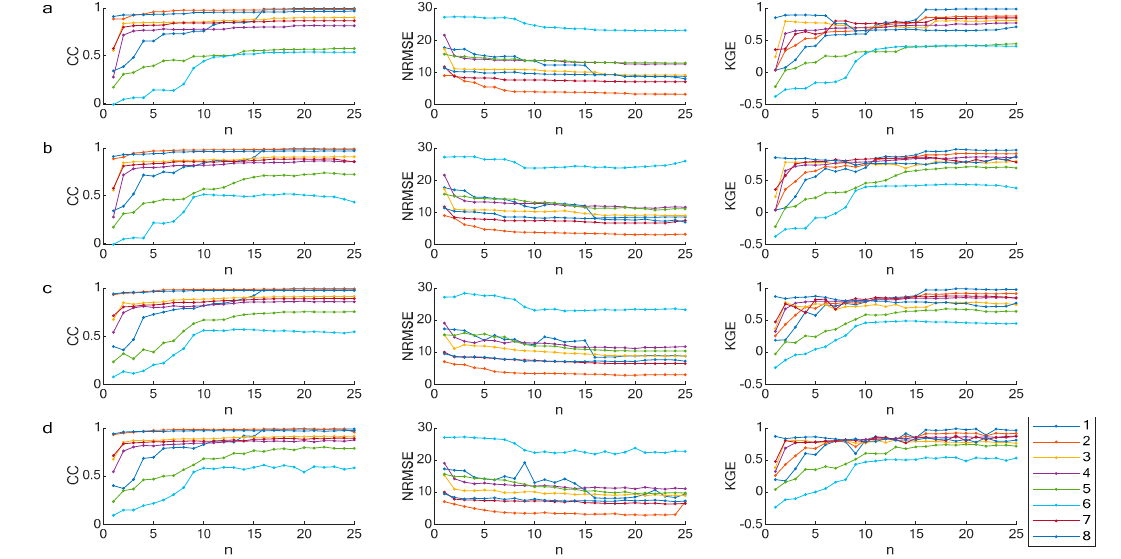
Figure 7. The model performance ( CC , NRMSE , and KGE ) depending on the number (n) of input variables form the PCA dataset in the validation phase. ( a )—LM, ( b )—LMI, ( c )—GPRexp, ( d )—NN. 1—air surface pressure (hPa), 2—air temperature (°C), 3—incoming photosynthetically active radi- 1—air surface pressure (hPa), 2—air temperature ( ◦ C), 3—incoming photosynthetically active radi- ation ( µ mol/m 2 /s), 4—relative air humidity (%), 5—wind speed (m/s), 6—wind direction (deg), 7—net radiation (W/m 2 ), 8—soil temperature at 5 cm ( ◦